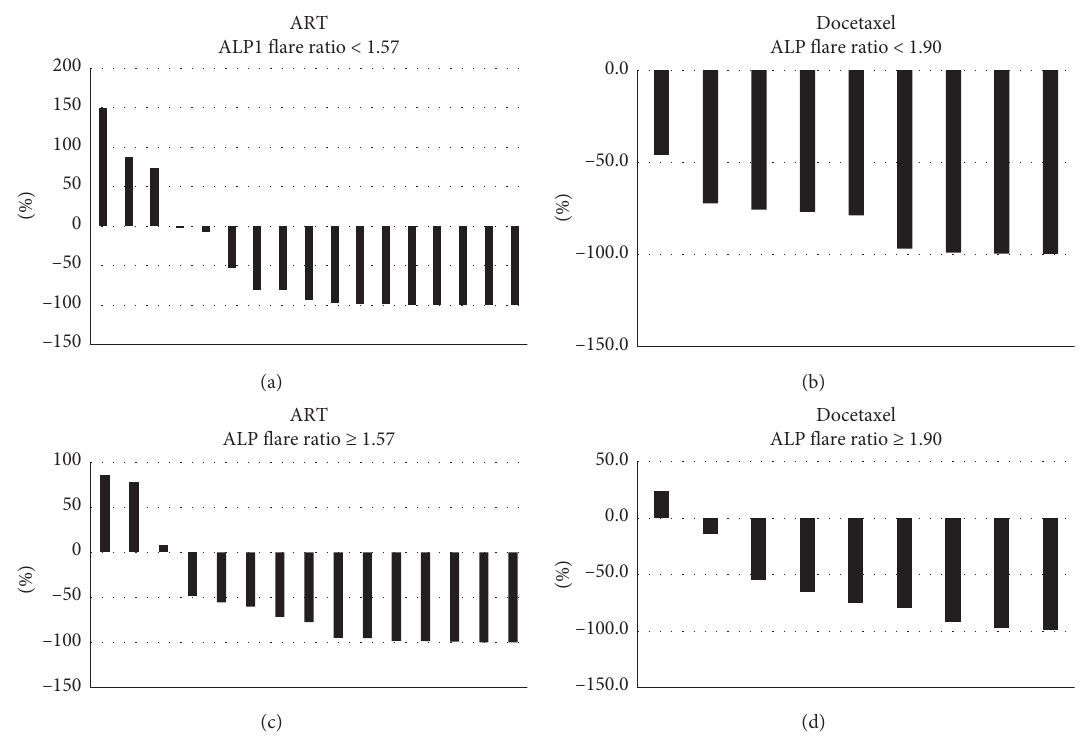
Figure 3: Waterfall plot of the best PSA decline after CRPC treatment compared with an ALP flare ratio less than 1.57 and 1.57 or more in the group that received second-generation androgen receptor targeting therapy (ART) (a, b) and an ALP flare ratio less than 1.90 and 1.90 or more in the group that received docetaxel (c, d).